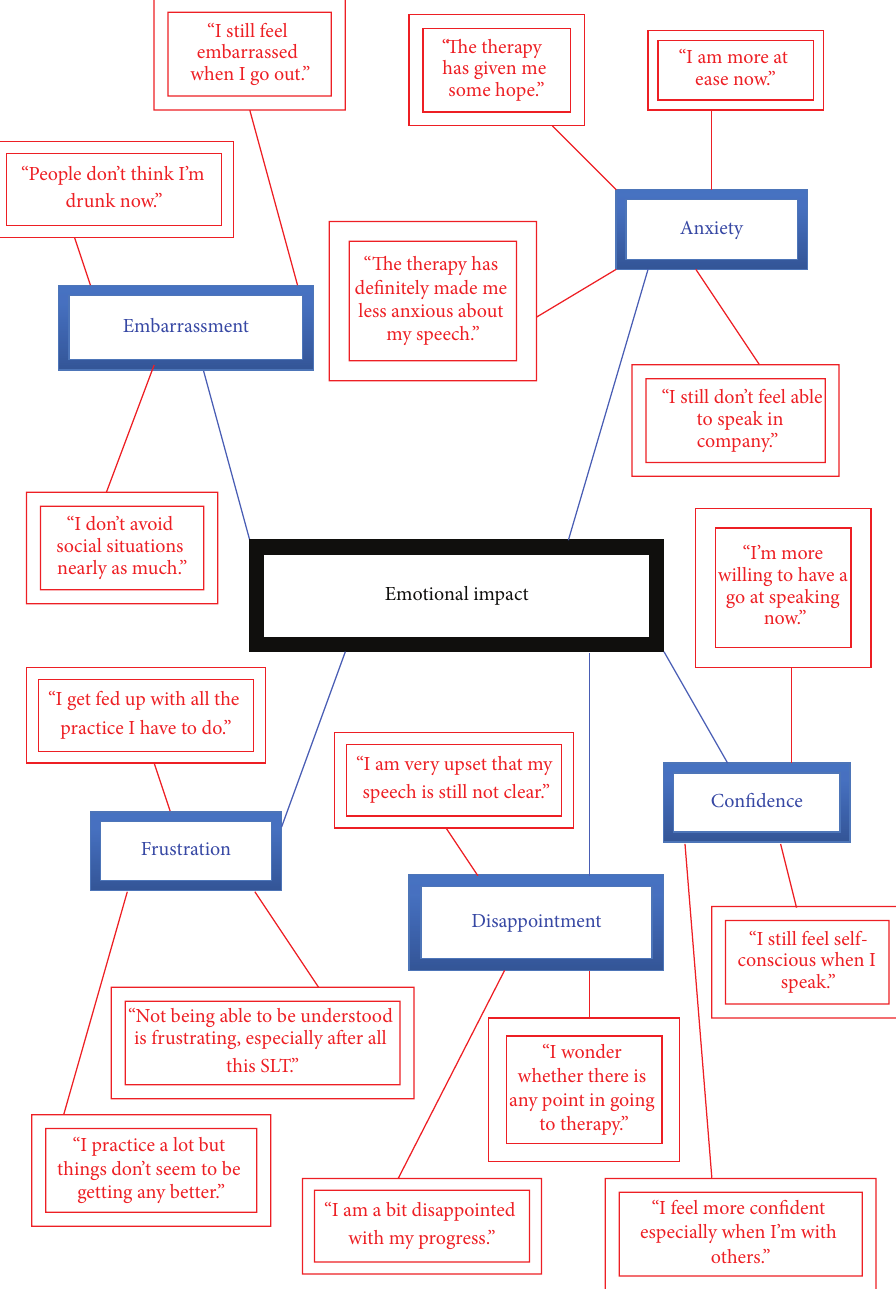
Figure 1: Thematic Network Analysis: emotional